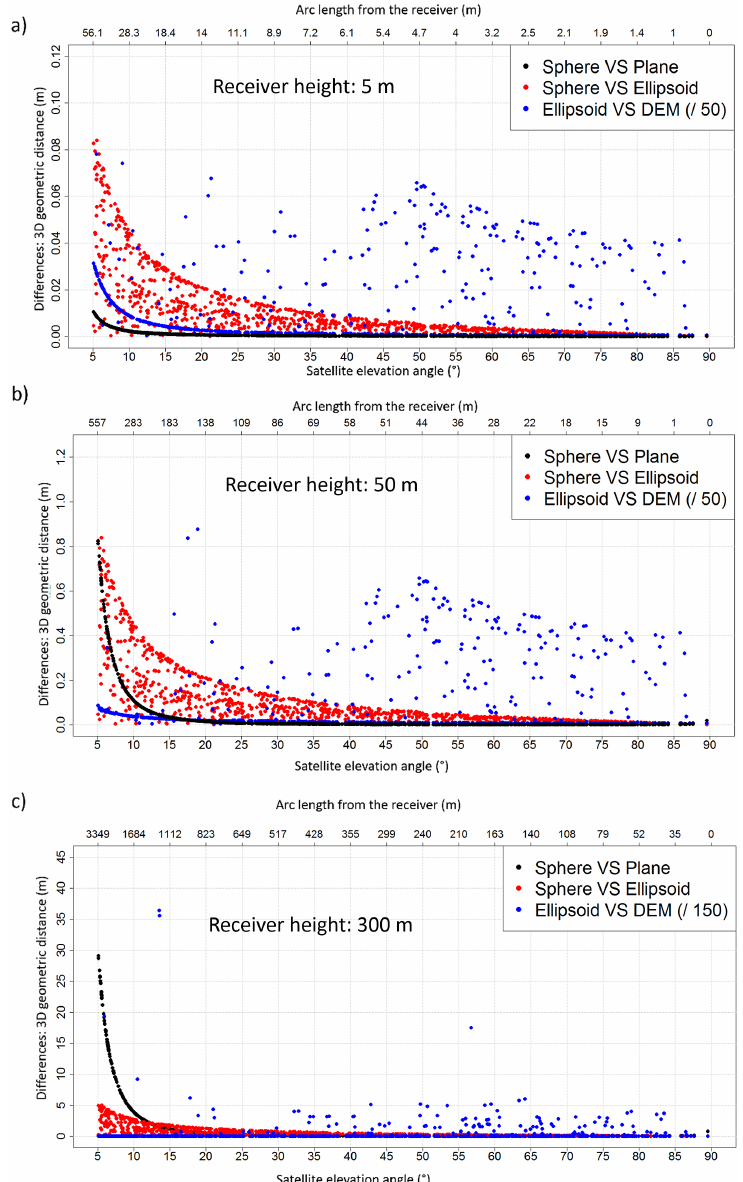
Figure 14. 3-D differences between the specular reflection points obtained with the different algorithms. Receiver heights above the reflecting surface of 5m (a) , 50m (b) and 300m (c) . Note the dispersion within results for a fixed elevation angle, which is a consequence of the azimuth variability in the ellipsoidal radius of